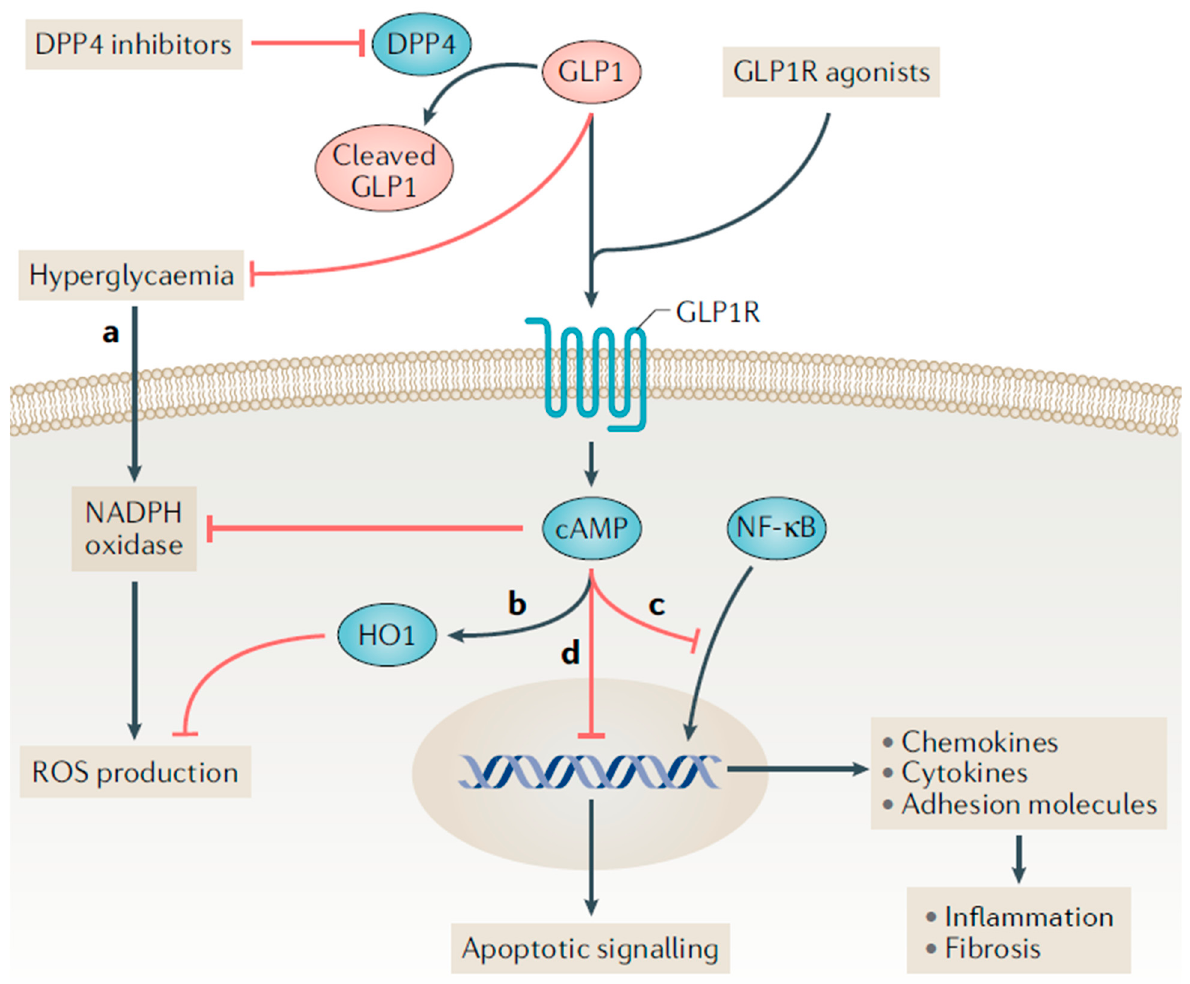
Figure 2. Proposed incretin signaling pathways in kidney cells. Legend: The glucagon-like peptide 1 receptor (GLP-1R) is a G protein-coupled receptor that can be activated by endogenously produced GLP-1 and synthetic GLP-1 receptor agonists. Dipeptidyl peptidase 4 (DPP4) inhibitors indirectly facilitate GLP-1R activation by preventing the rapid degradation of endogenous GLP-1 in circulation. ( a , b ) GLP-1 receptor agonists may reduce the production of reactive oxygen species (ROS) through receptor-mediated and non-receptor-mediated mechanisms. Haem oxygenase 1 (HO1) is upregulated by GLP-1 receptor agonists and protects against oxidative stress in ischemia-reperfusion injury. ( c ) GLP-1R activation inhibits the binding of nuclear factor- κ B (NF- κ B) p65 to its target genes, which may reduce the downstream expression of chemokines, cytokines (such as tumor necrosis factor, IL-1 β , IL-6 and transforming growth factor- β ), and pro-fibrotic factors and adhesion molecules (such as intercellular adhesion molecule 1, vascular cell adhesion molecule 1, and E-selectin). ( d ) Administering a DPP-4 inhibitor to mice reduced the ratio of the apoptosis regulator BAX to the apoptosis regulator BCL-2, and the ratio of BCL-2-like protein 11 to BCL-2; this effect suggests a decrease in apoptosis. Whether this anti-apoptotic effect is directly medicated by DPP4 inhibitors or by GLP-1R activation is uncertain. Reprinted with permission from Ref. [28].